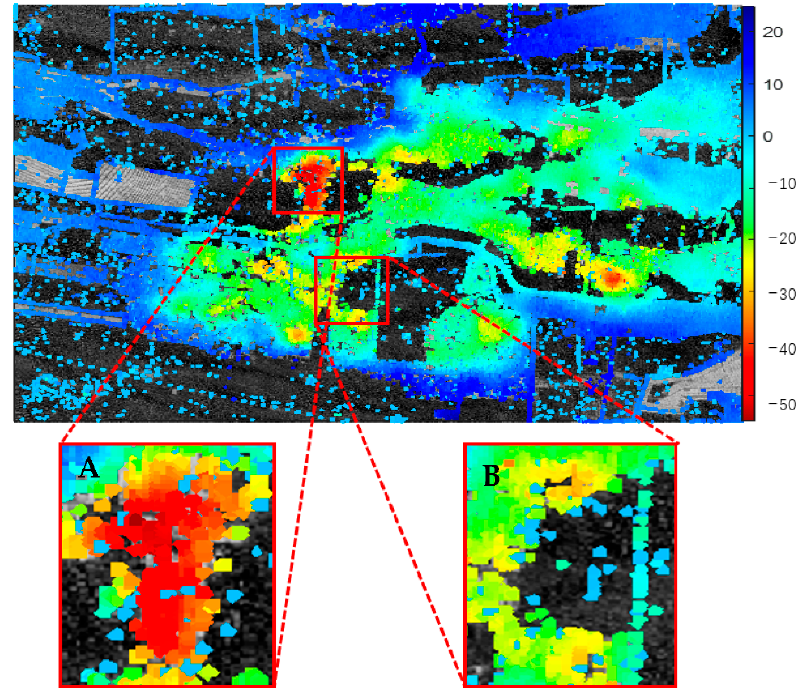
Figure 14. The land deformation estimated using MLE combining PSs and DSs. ( A ) Site A, ( B ) Site B.